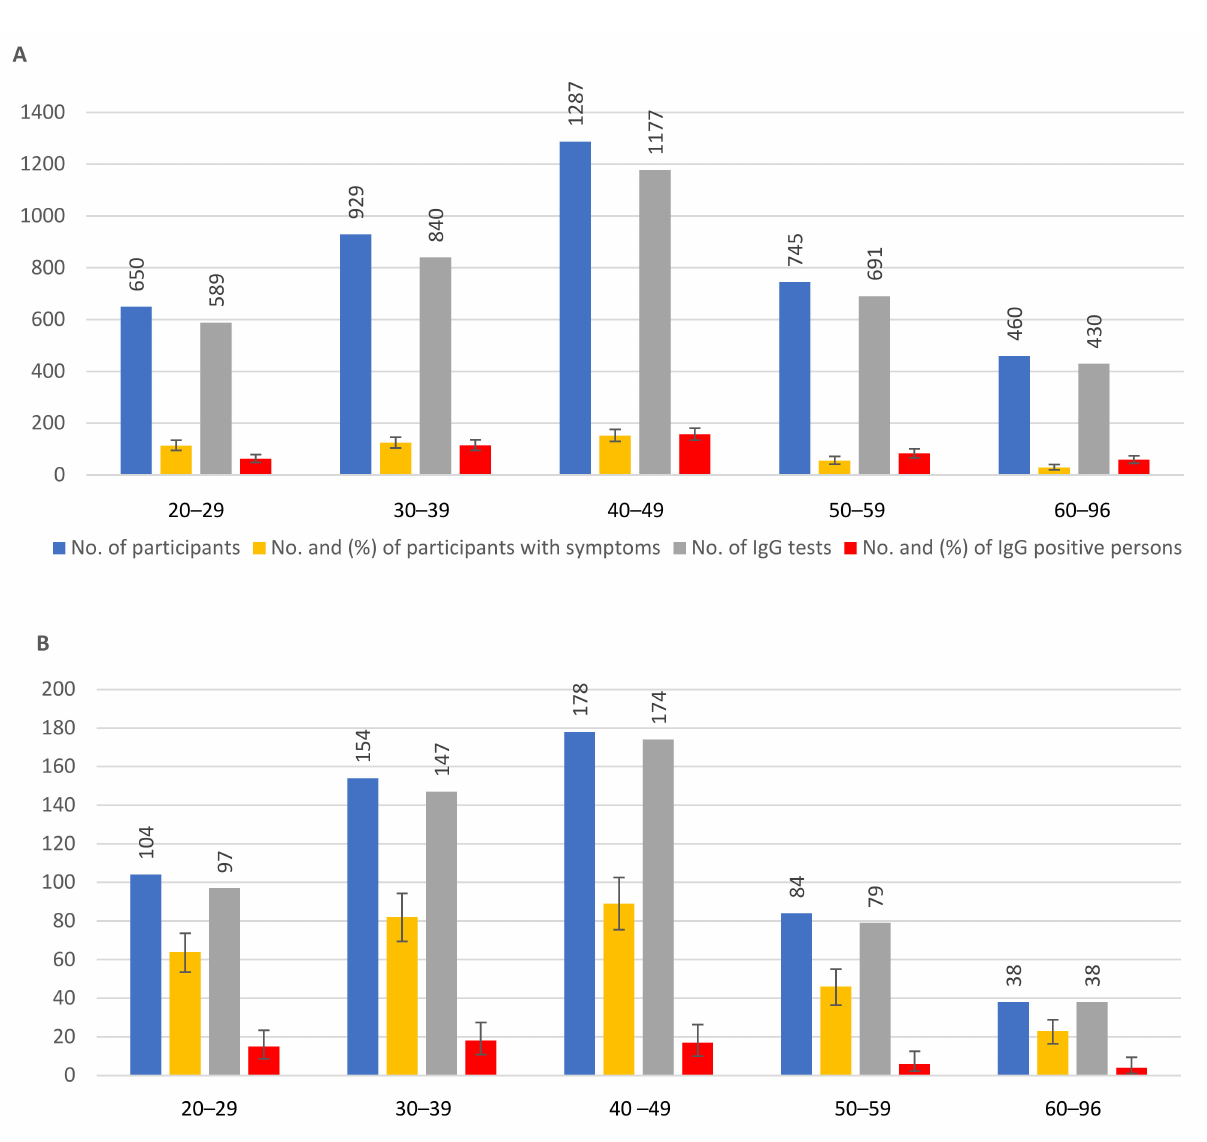
Figure 3. Age distribution of IgG-positive and symptom-positive people in the group of participants without known COVID-19 contacts ( A ) and in the group with known COVID-19 contacts ( B